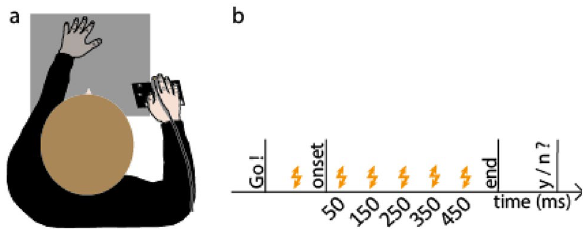
Figure 1. ( a ) Top view of setup and ( b ) trial schedule of Experiments 1 and 3. Participants started a right-hand reaching movement after a Go-cue toward their unseen left thumb or index finger. A brief vibrotactile probing stimulus was presented on their right index finger (Experiments 1 and 2; illustrated here) or their left little finger (Experiment 3) at several moments during the trial (thunderbolts in panel ( b ), here times are shown for Experiments 1 and 3). After the end of the reach, participants responded as to whether or not they detected the probing